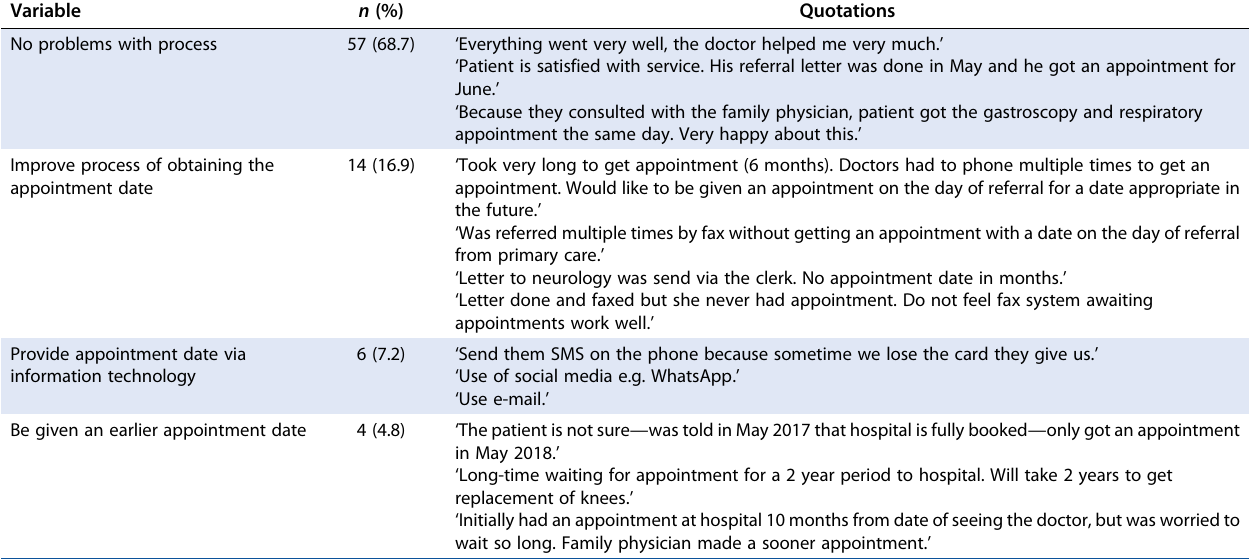
Table 4: Patients ’ feedback on their experience of being referred at primary care facility ( n = 83) Variable n (%)